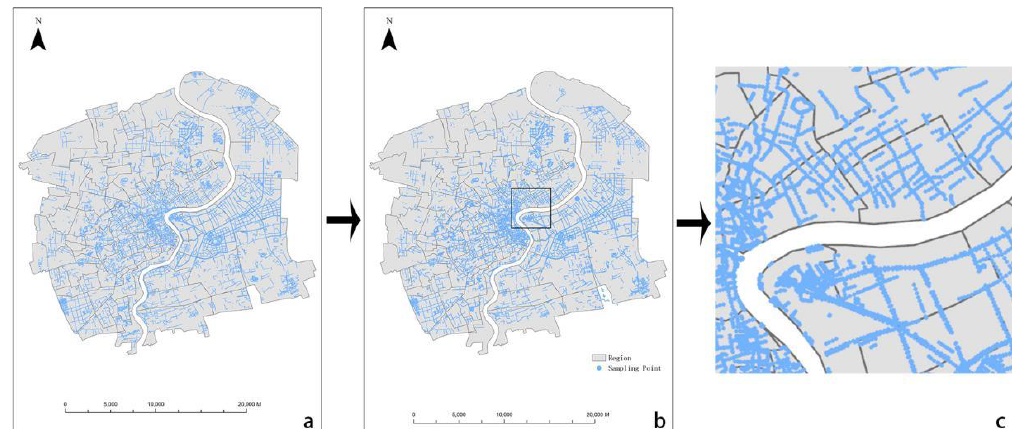
Figure 2. Street network and sampling points. ( a ) holistic street network of the study area; ( b ) downtown area ( c ) zooming example.